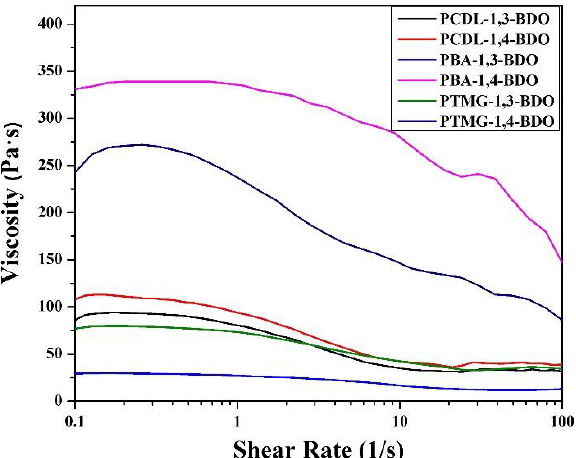
Figure 7. Shear thinning characteristics of TPUs produced by applying 1,3-BDO or 1,4-BDO during the synthesizing of PBA, PTMG, or PCDL.